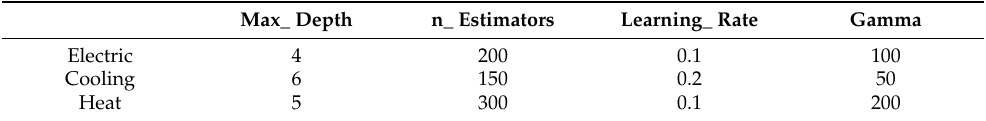
Table 4. Hyper parameter setting.